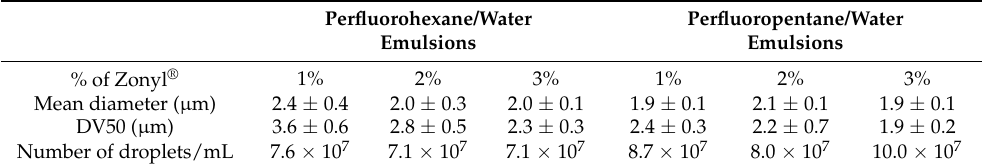
Table 2. Average number of droplets per milliliter and the diameter measured by optical microscopy and the corresponding mean diameter measured by Mastersizer ® for a given composition of the emulsion at 25 ◦ C.